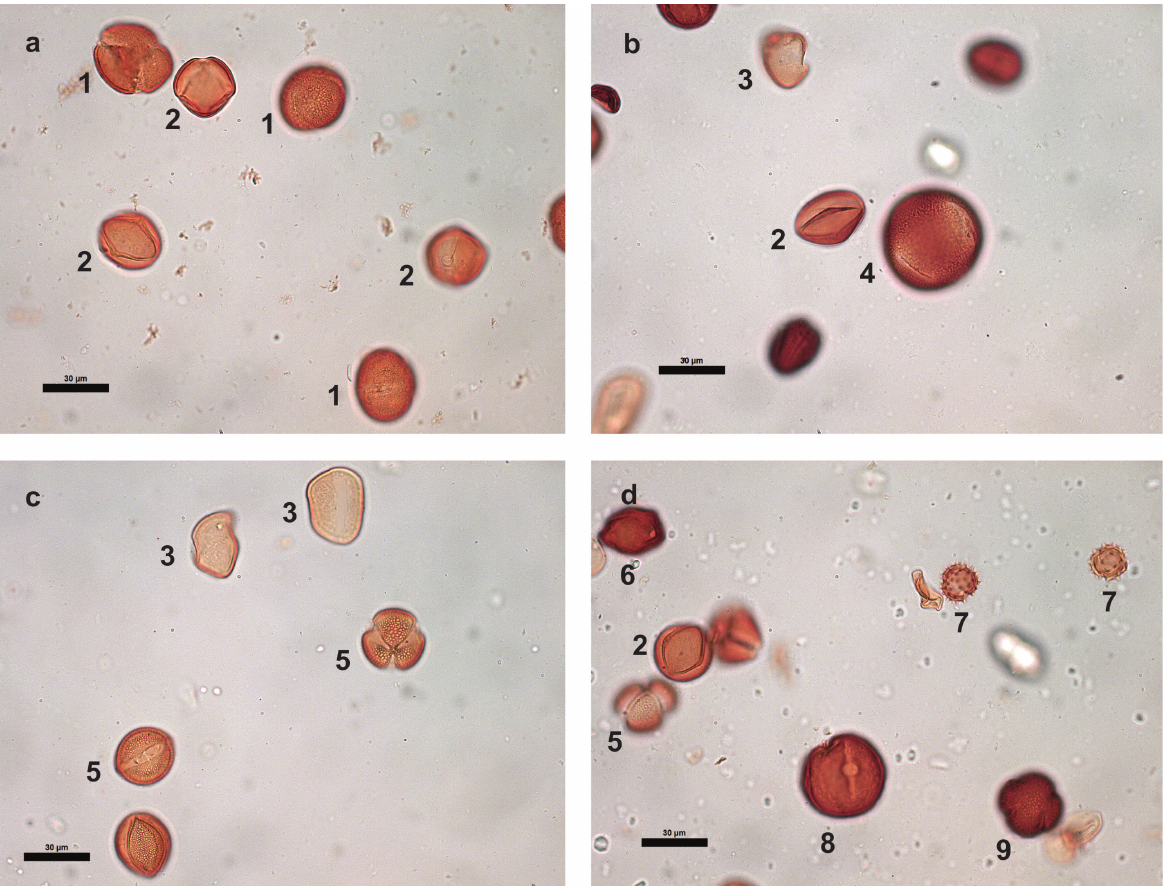
Figure 2 - Pollen types in pollen loads of G. argentina (a), P. catamarcensis (b) and T. angustula fiebrigi (c), and in garbage pellets of T. angustula fiebrigi (d): 1_ Pisonia zapallo ; 2_ Prosopis ; 3_ type Arecaceae-Asparagaceae-Asphodelaceae; 4_ Rhipsalis lumbricoides ; 5_ Handroanthus impetiginosus ; 6_ Casuarina cunninghamiana ; 7_type Baccharis - Mikania ; 8_ Melia azedarach ; 9_ Citrus . Bar = 30